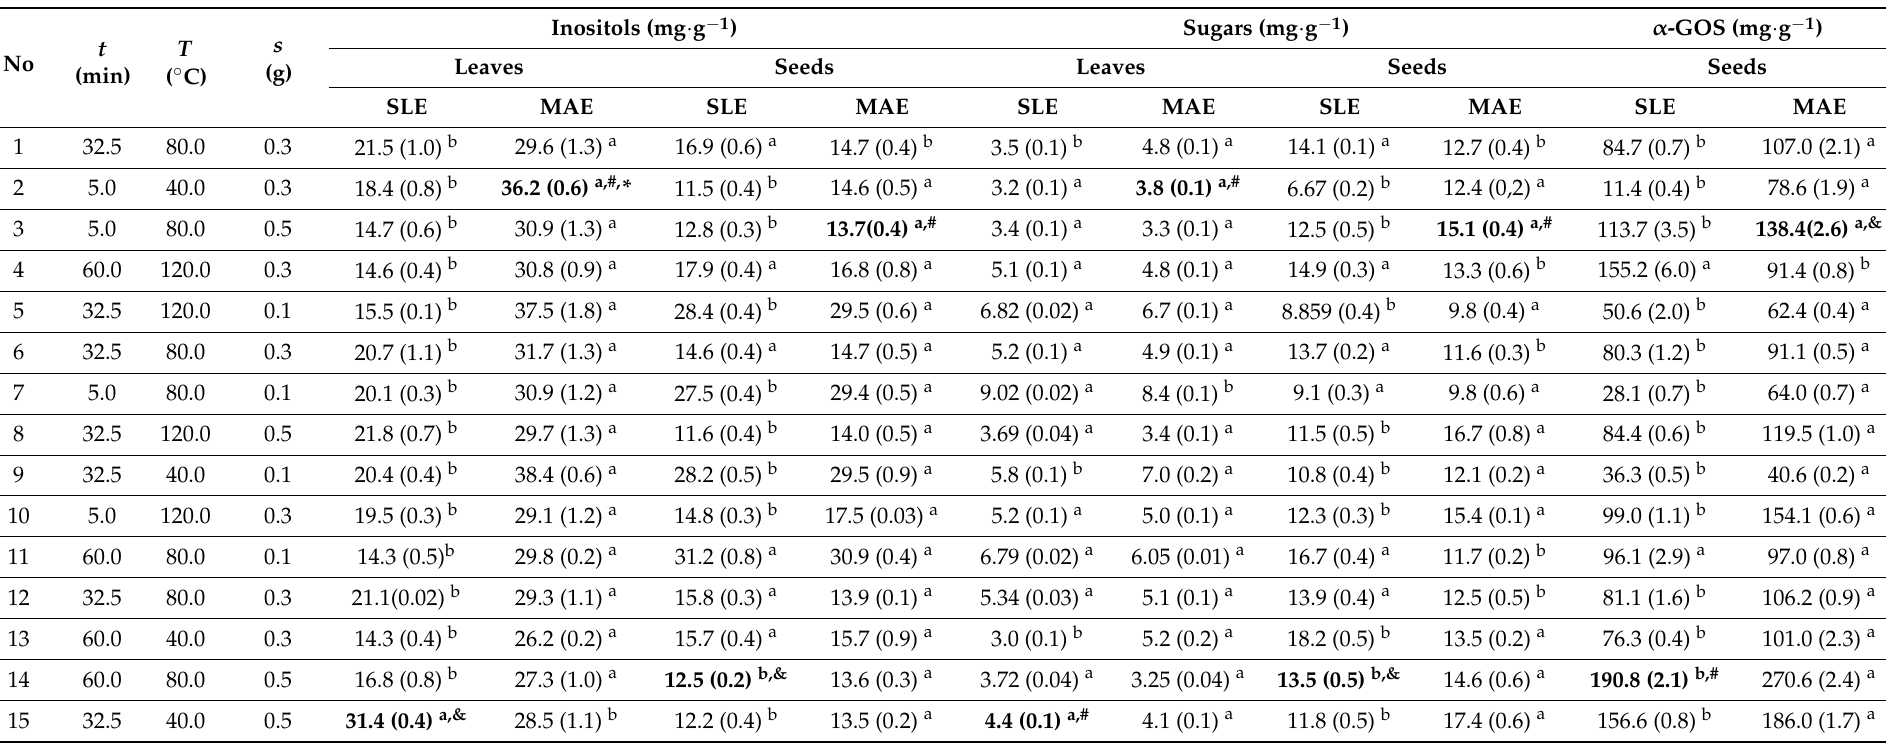
Table 1. Experimental Box–Behnken design and inositols, sugars, and α -GOS content obtained by SLE and MAE (mg · g − 1 ). Standard deviation in brackets ( n =